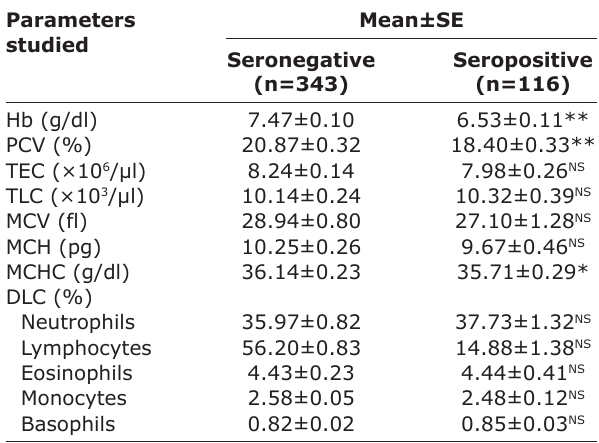
Table-1: Details of hematological parameters studied in goats. Parameters studied